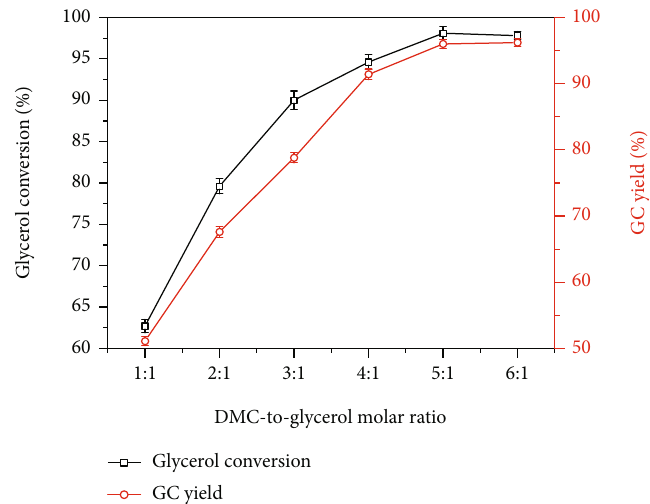
Figure 8: E ff ect of DMC-to-glycerol molar ratio on glycerol conversion and GC